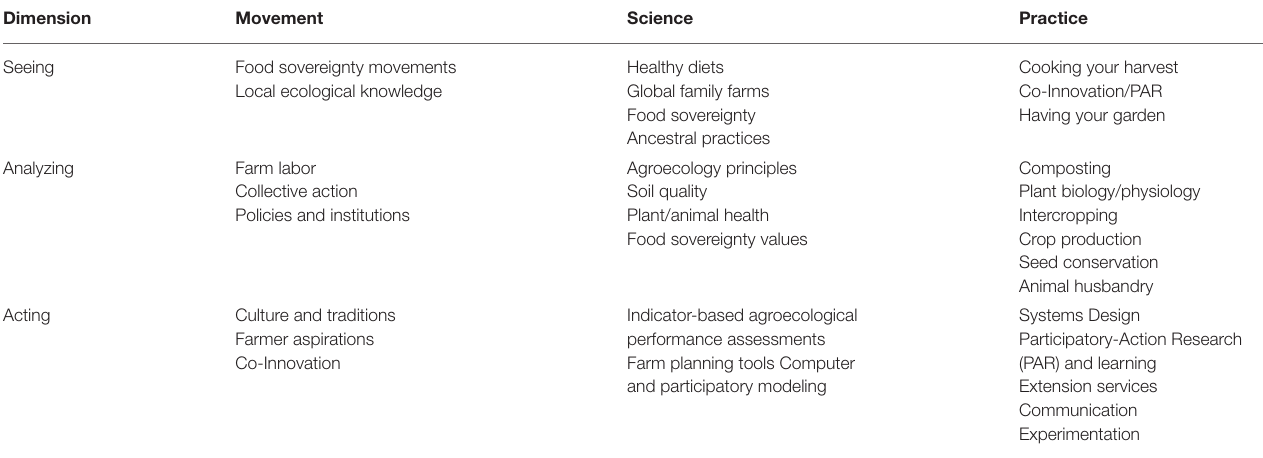
TABLE 1 | A proposal of methodologies and course contents for an online (or hybrid) introductory agroecology curriculum that integrates Liberation Pedagogy by Paolo Freire and the dimensions of agroecology: movement, science, and practice.